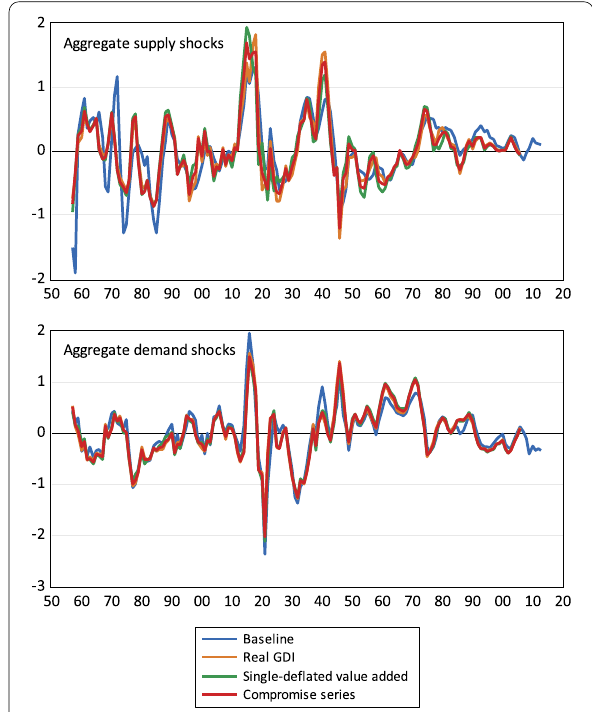
Fig. 12 Aggregate supply and demand shocks using alternative output and inflation data provided in Stohr